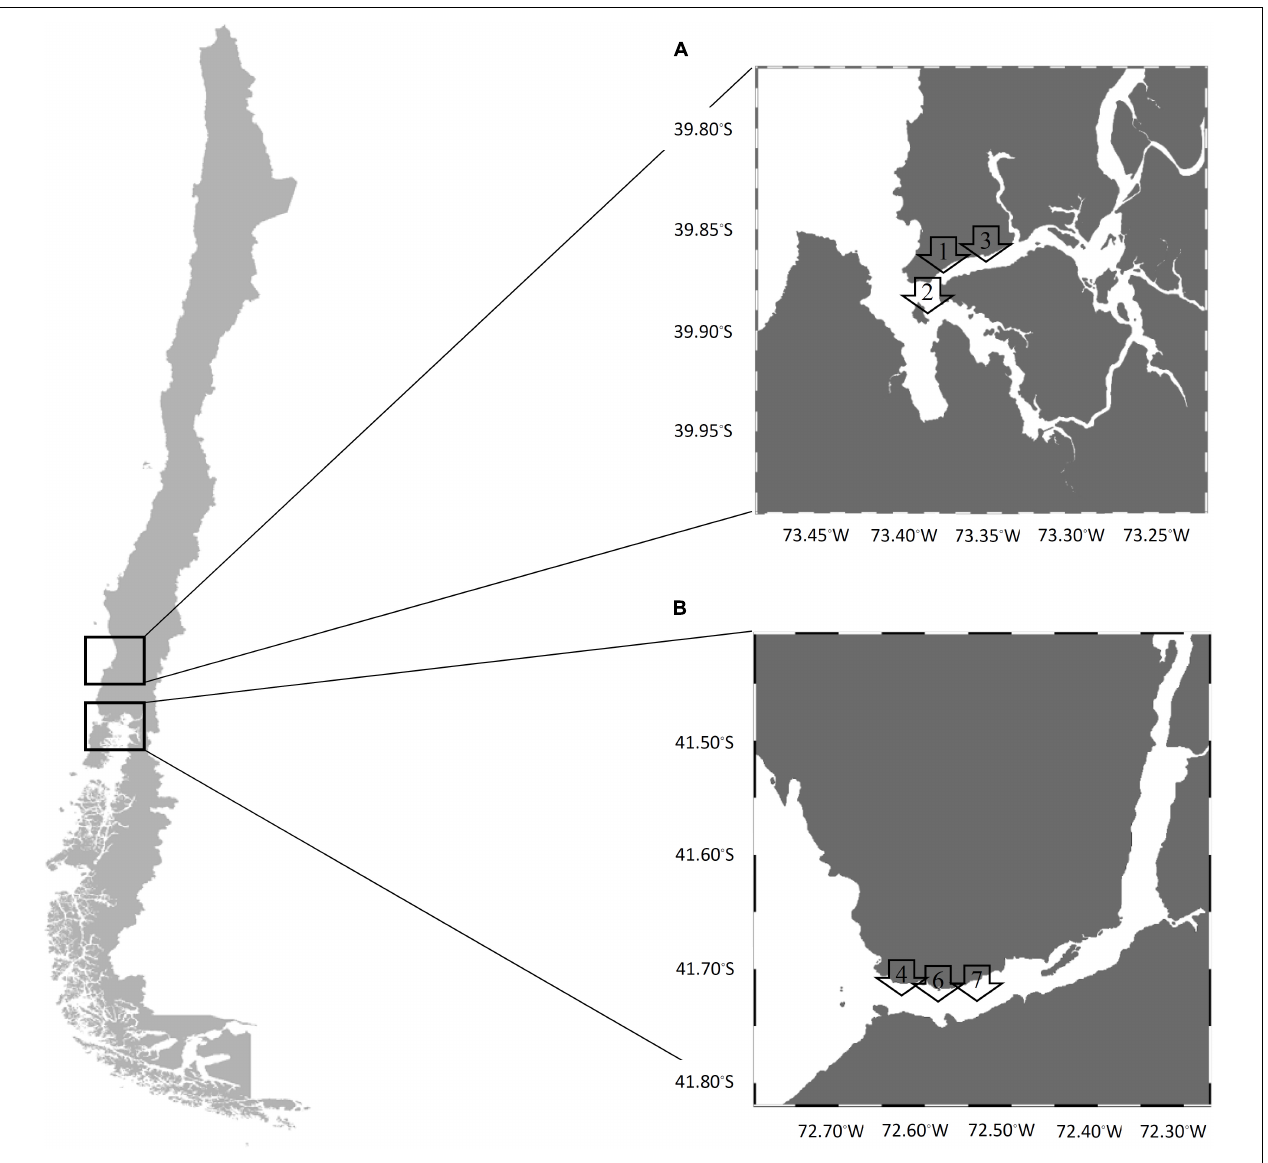
FIGURE 1 | Sampling map in the southern Chile coast (A) Valdivia River Estuary and (B) Reloncaví Fjord. Arrows denote the sites of each sampling